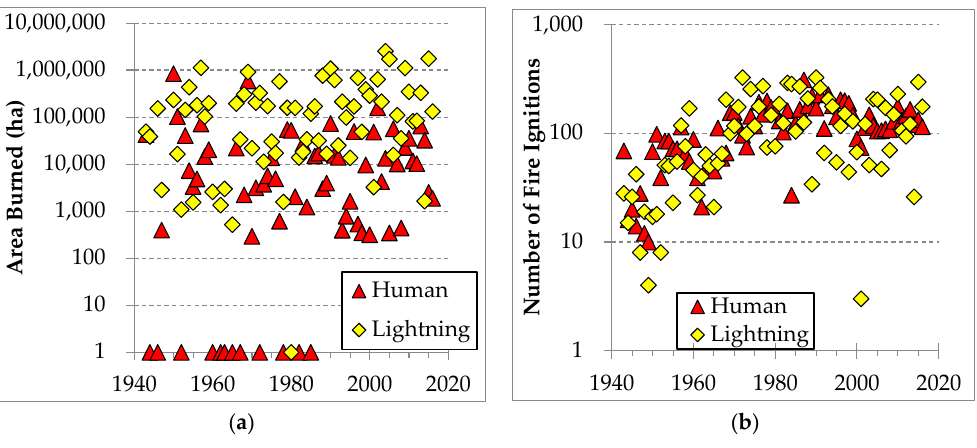
Figure 2. Temporal trends in ( a ) annual area burned (ha) and ( b ) number of annual fire ignitions by cause in interior Alaska from 1943 to 2016.